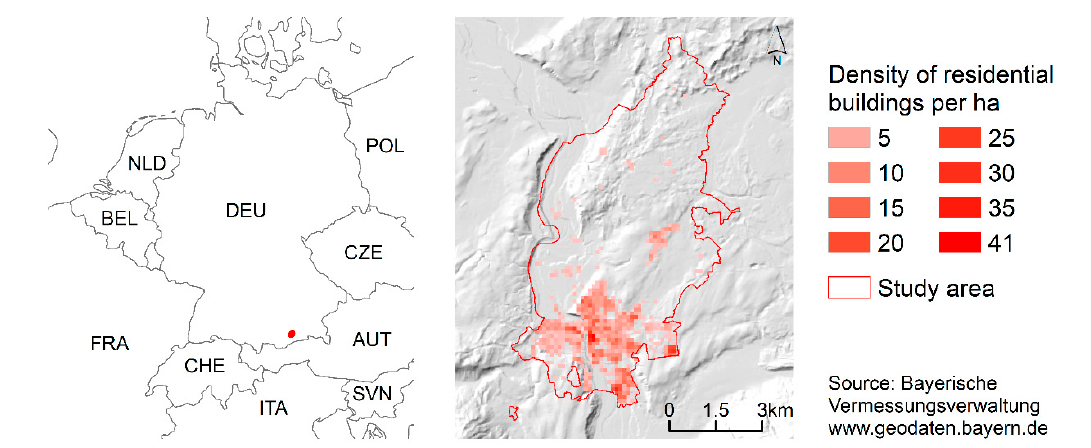
Figure 1. Location of the study area and distribution of residential buildings (Data source: [38–40] ).